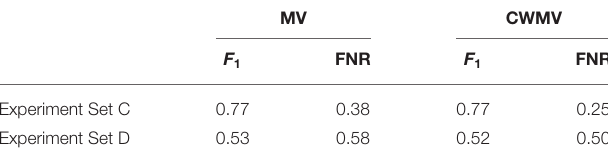
TABLE 4 | Performance analysis of voting methods for imbalanced